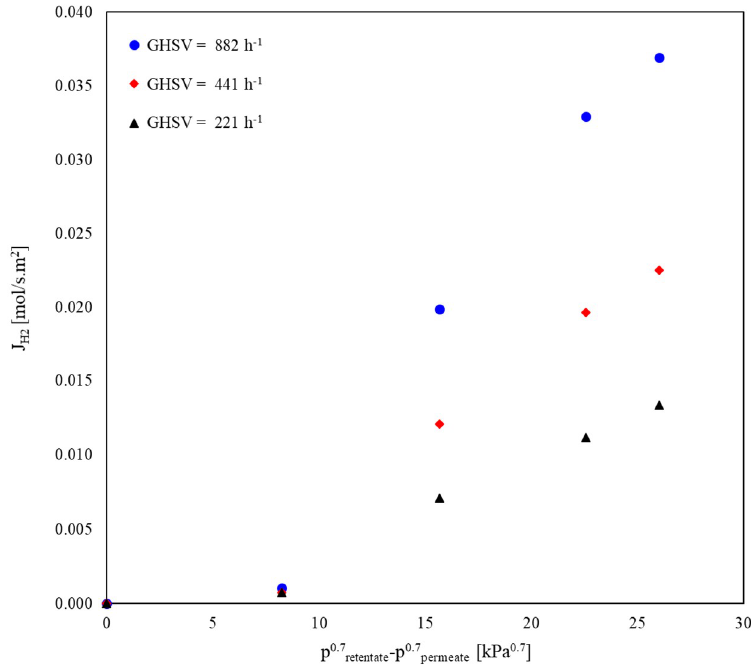
Figure 10. Influence of GHSV on the H 2 permeating flux using Pd/YSZ membrane.